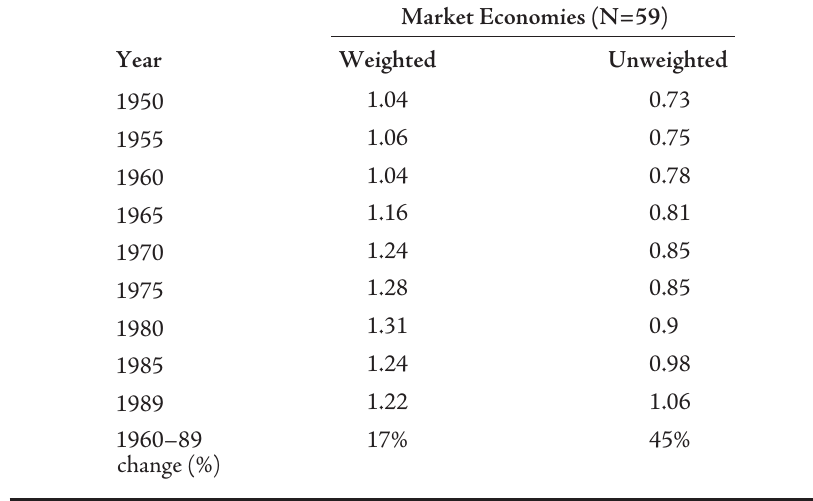
Table 1 – PWT World Income Inequality (VarLog) All Cases (N=120)